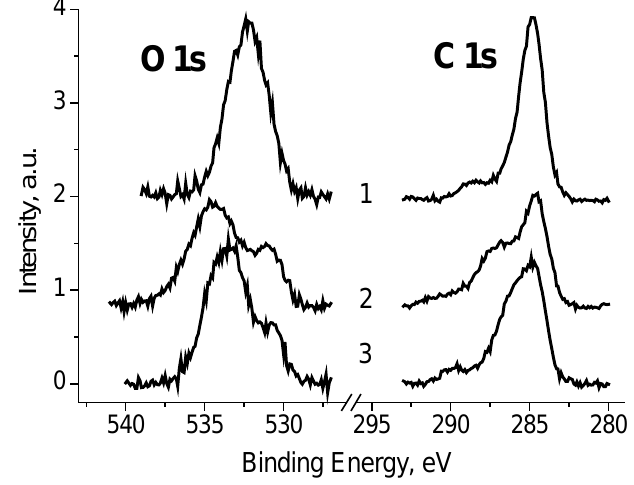
Figure 6. The C 1s and O 1s photoelectron spectra of Ag black measured at different U b = +7 (1), − 7 (2), 0 V (3).